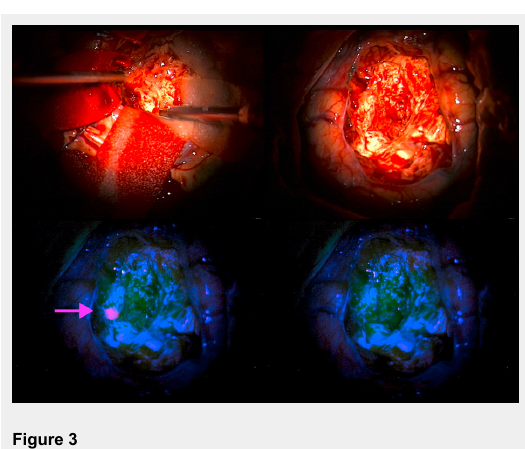
The oral prodrug 5-ALA identifies tumour tissue in surgery for glioblastoma. Top left: intraoperative view during tumour resection. Top right: surgical site after removal of all tumour tissue as seen in white light microscopy. Bottom left: upon switching to microscopic blue light a small patch of remaining tumour tissue can be seen thanks to 5-ALA fluorescence (arrow). Bottom right: surgical site after removal of all fluorescent tumour.